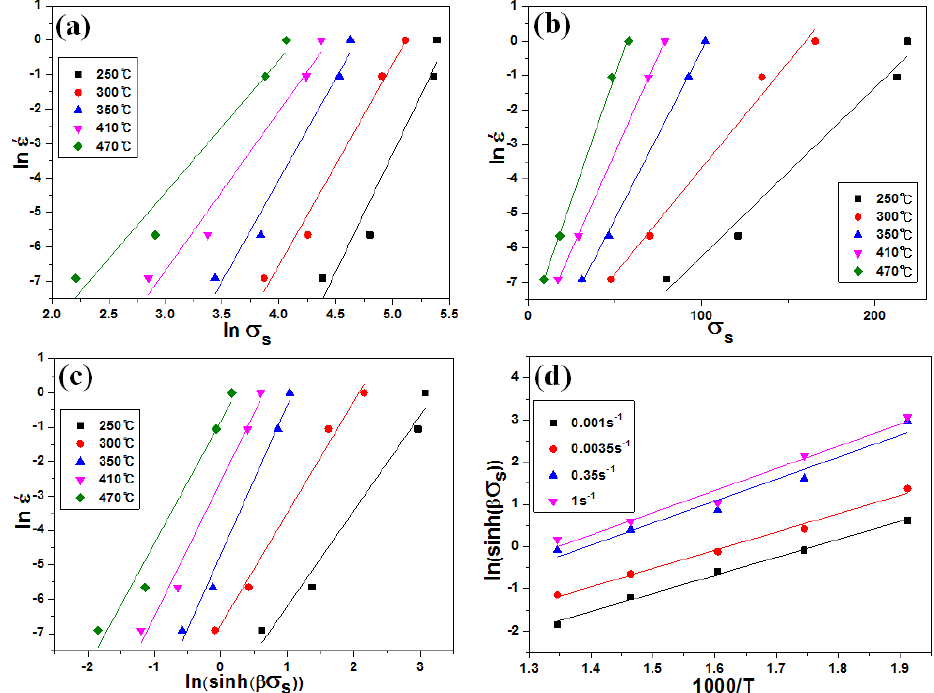
Figure 8. Relationship between steady-state stress, strain rate and temperature: ( a ) ln( έ ) versus ln( σ ); ( b ) ln( έ ) versus σ ; ( c ) ln( έ ) versus ln[sinh( βσ )]; ( d ) ln[sinh( βσ )] versus 1000/T.